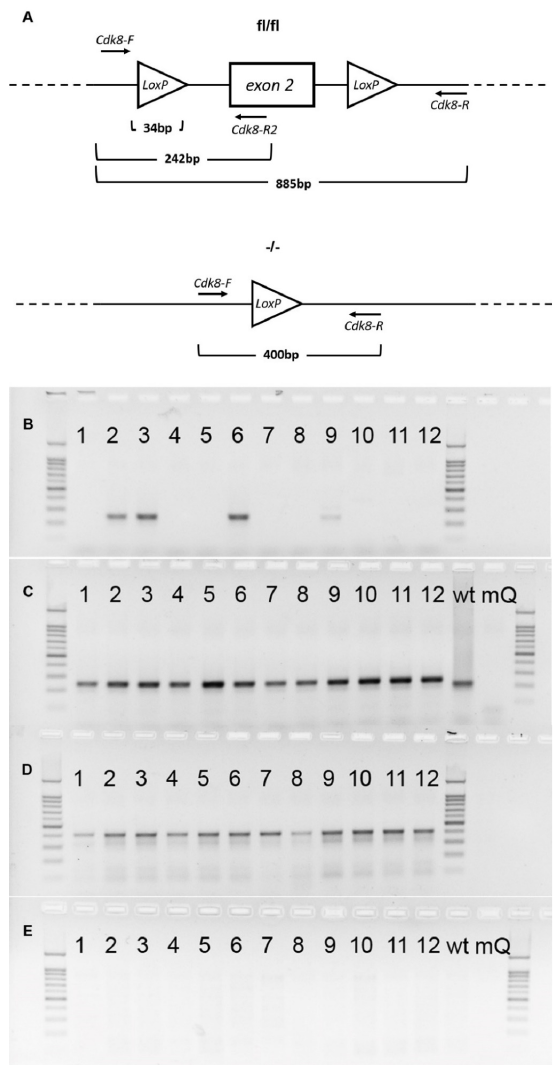
Figure 2. ( A )—Schemes of loxP-sites localization in Cdk8 gene of Cdk8 fl/fl mice (upper scheme) and Cdk8 − / − mice (lower scheme) and annealing positions of PCR primers used for genotyping of ani-